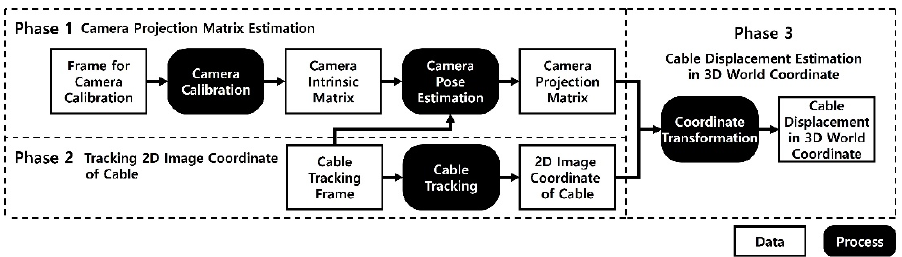
Figure 2. Overview for cable displacement measurement using side view video.